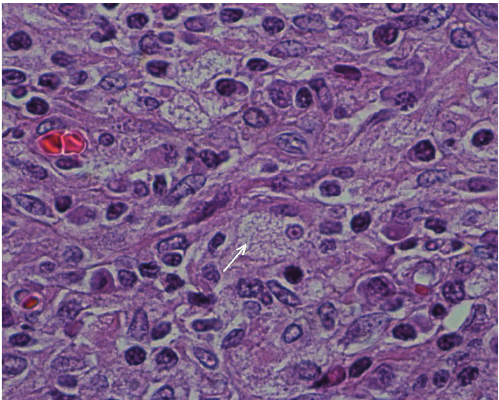
Figure 3: Numerous foamy histiocytes forming granulomas with occasional plasma cells and lymphocytes (1000x